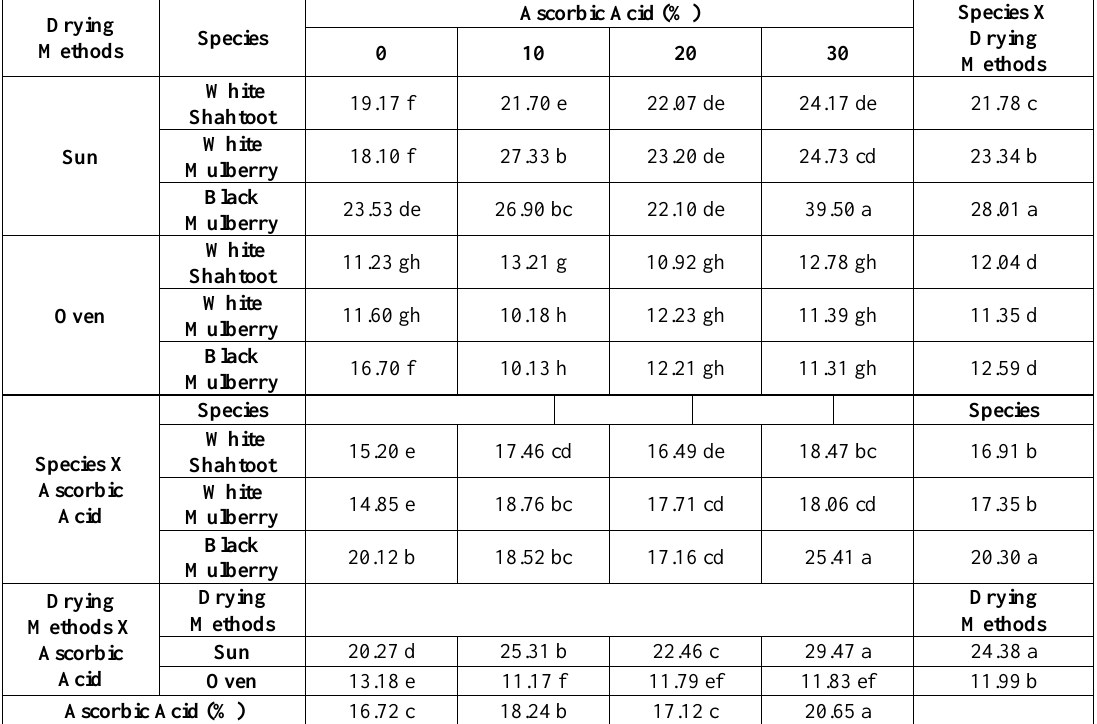
Different letters in each factor and their interactions indicate a statistical difference between treatments according to Duncan‟s multiple ranges